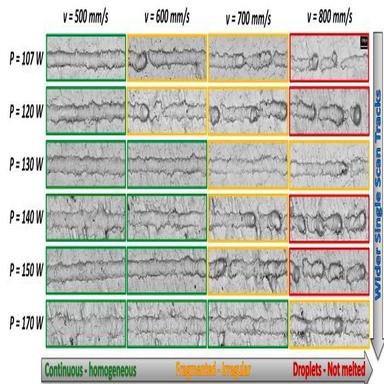
SEM images of the Single Scan Tracks (SSTs) obtained using different scan laser Power (P) and Scan Speed (v).